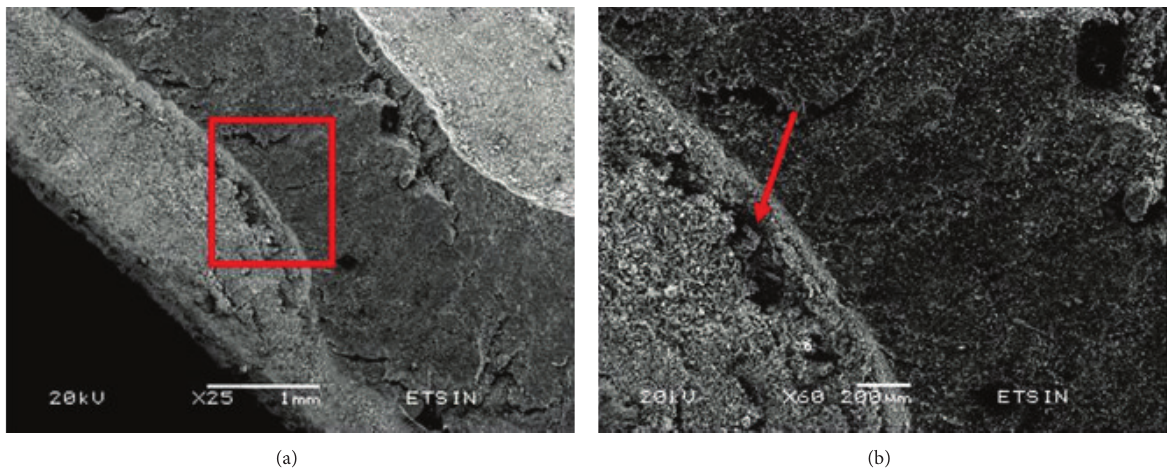
Figure 4: SEM image of the surface of polyurethane adhesive MCB specimens after fracture. Following a 32-day seawater immersion